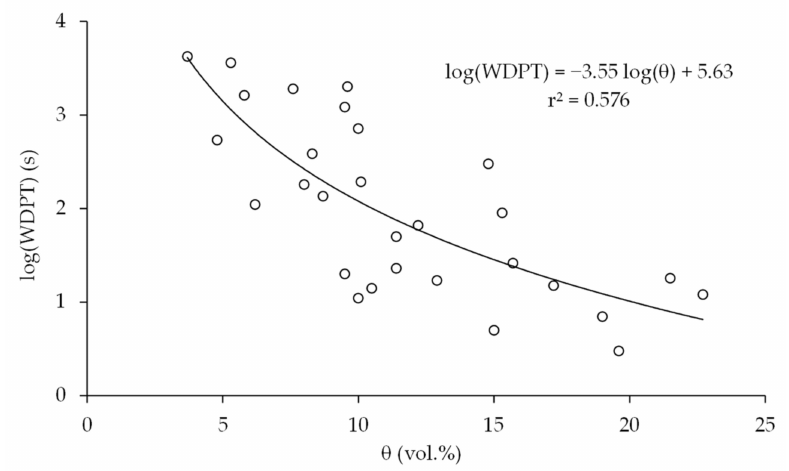
Figure 4. Average values of the water drop penetration time (WDPT) detected at the O/A-interface as a function of soil water